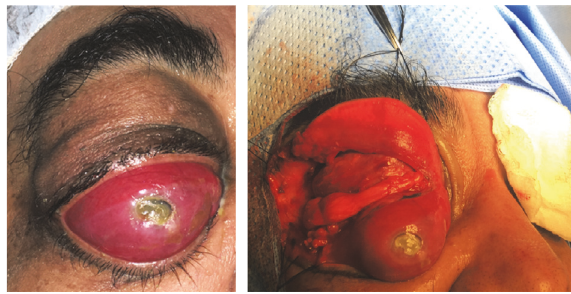
Figure 2: Anterior view with total corneal opacity.